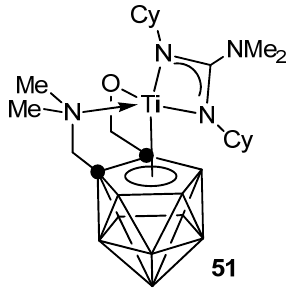
Figure 29. Metallocarborane complexes of titanium.